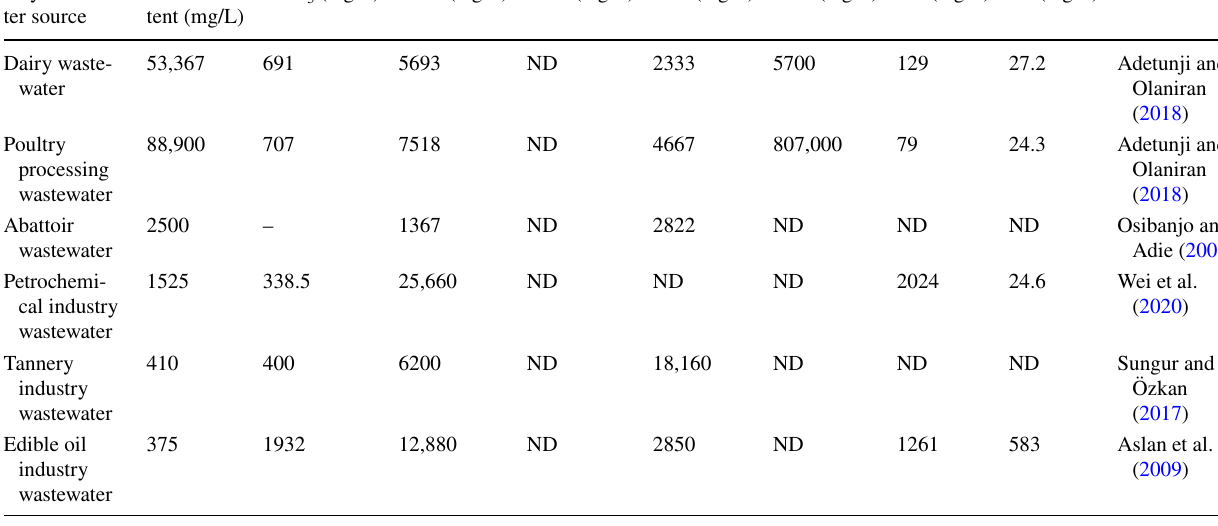
ND Not detected, TOC Total organic carbon, TN Total nitrogen, TP Total phosphorus